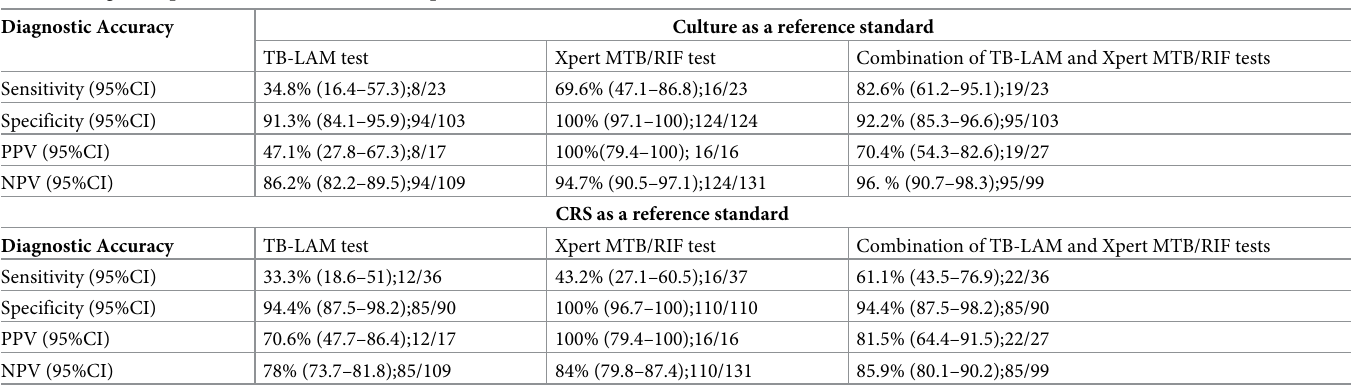
Table 2. Diagnostic performance of TB-LAM and Xpert MTB/RIF